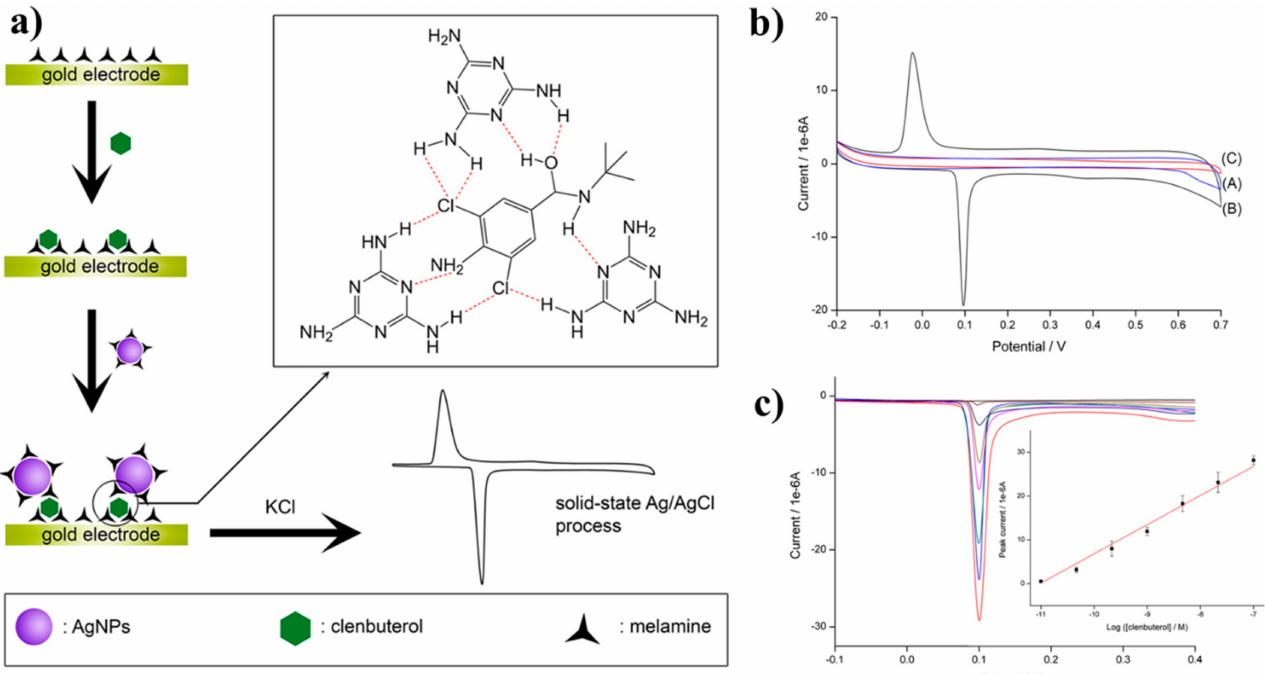
Figure 5. ( a ) Schematics of the melamine-silver nanoparticles (M-Ag NPs)-based sensor for clenbuterol determination. ( b ) CV response of the sensor in the presence of (A) 0, and (B) 1 nM clenbuterol. (C) melamine modified Au electrode at a scan rate of 100 mV/s in the presence of 0.1 M KCl. ( c ) The LSV response of the sensor in the presence of different concentrations of clenbuterol (0–100 nM). Inset shows the corresponding linear calibration plot (n = 3). Reproduced with permission from [24]. Copyright © 2020 American Chemical